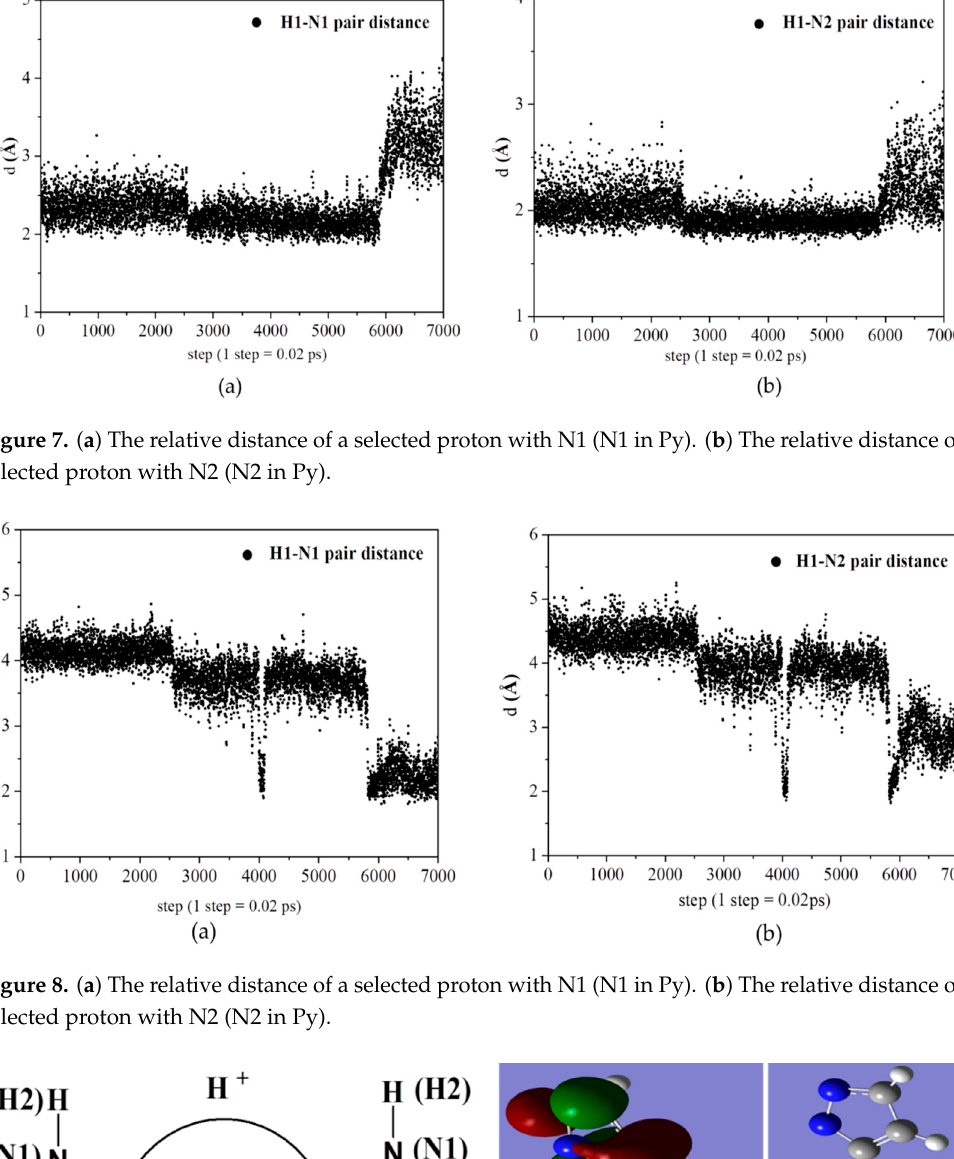
Figure 7. ( a ) The relative distance of a selected proton with N1 (N1 in Py). ( b ) The relative distance of a selected proton with N2 (N2 in Py).